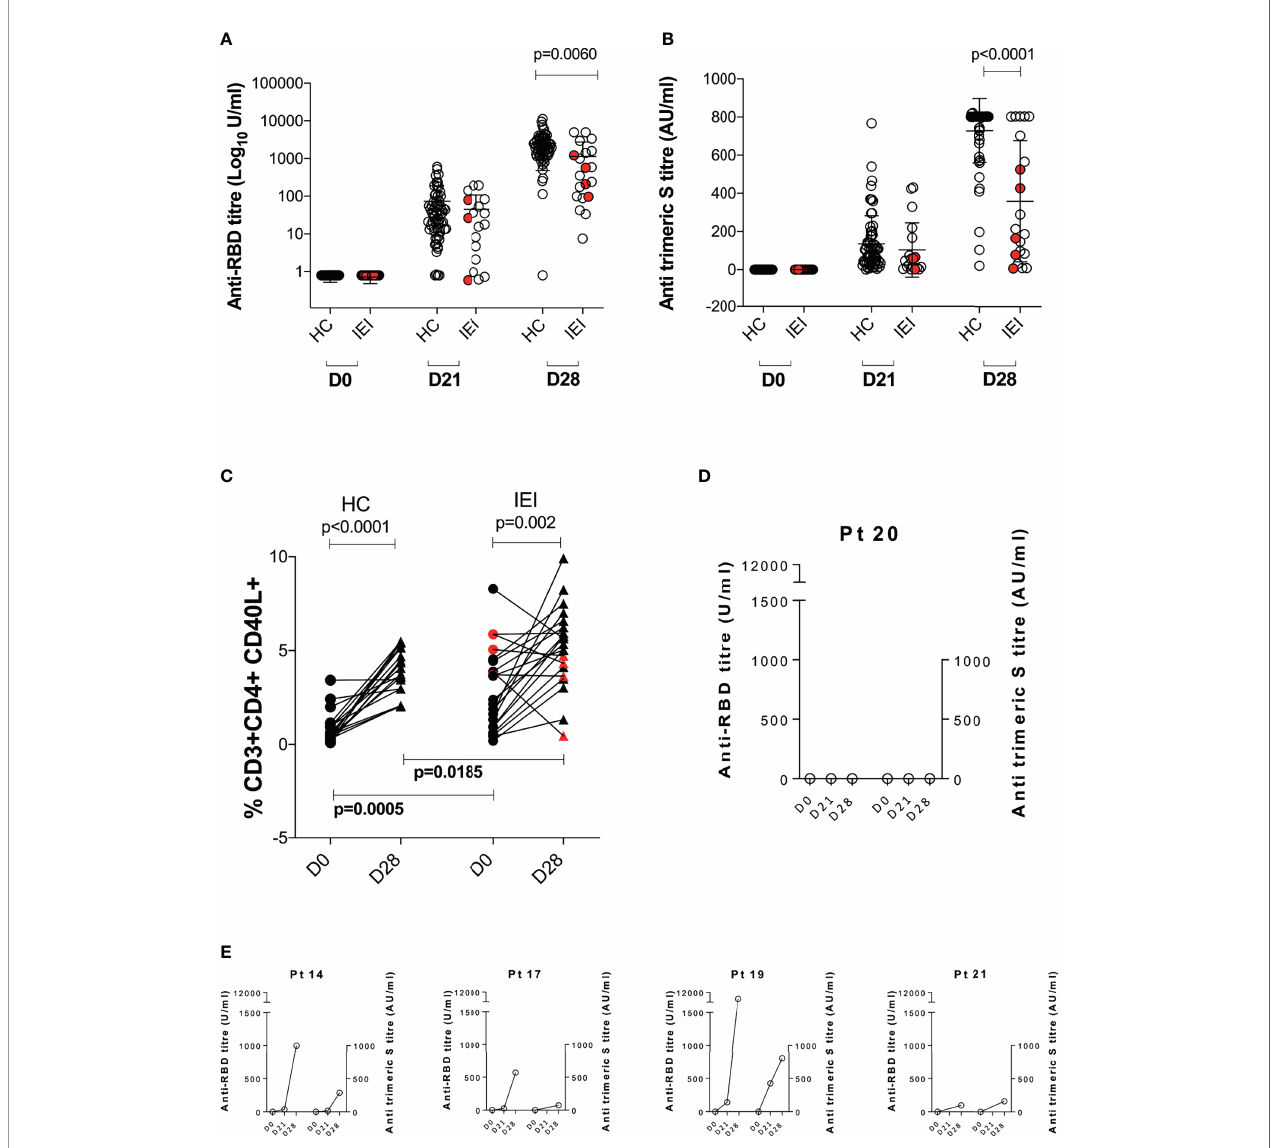
FIGURE 1 | Anti-SARS-CoV-2 immune response before (D0) and at 21 days (D21) after the 1° dose and at 7 days (D28) after the 2° dose of the BNT162b2 mRNA COVID-19 vaccine. Humoral response is represented in (A) anti-RBD Ab (Log 10 U/ml) and (B) anti-trimeric S titer (AU/ml). Cellular response is depicted in (C) . Humoral response of fi ve patients lacking any cellular response is reported in (D, E) . Non-paired non-parametric Mann – Whitney test was used in (A, B) ; paired non-parametric Wilcoxon tests were used to assess differences between D0 and D28 in HC and IEI in (C) . HC, healthy controls; IEI, inborn errors of immunity